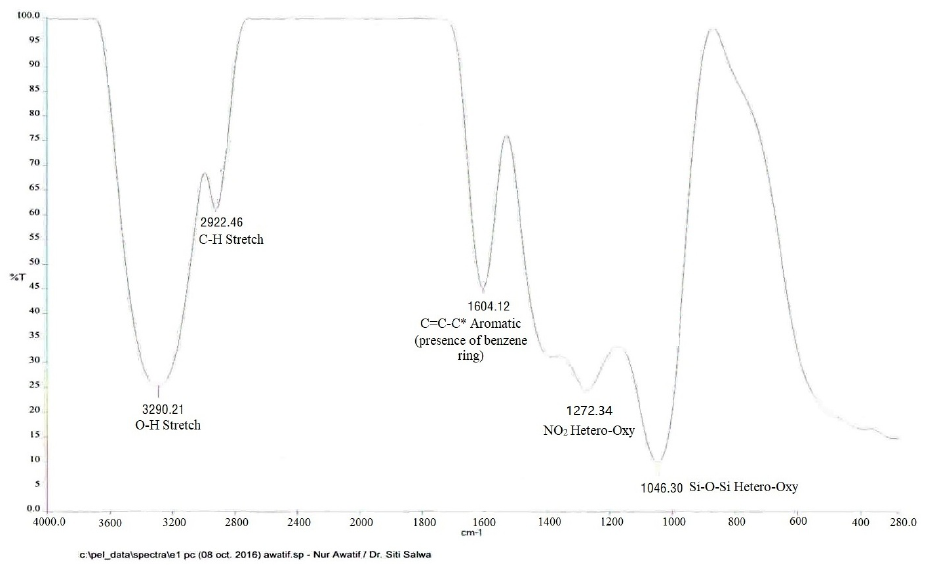
Figure 6. FT-IR of ethanol fruit extracted P. macrocarpa.